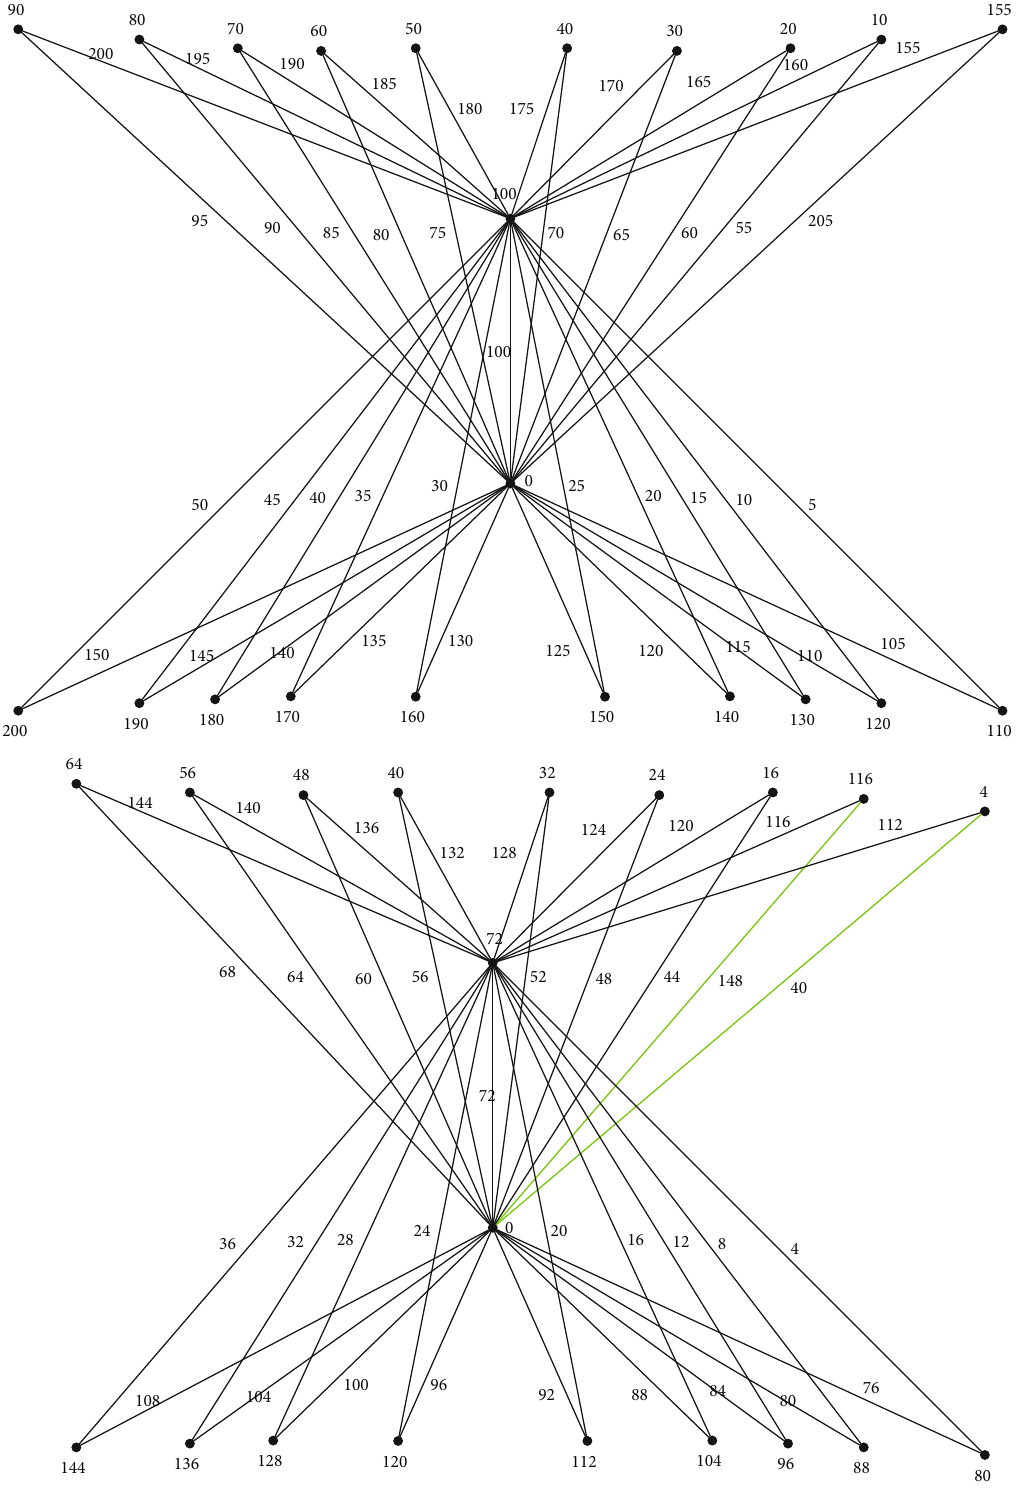
− graceful labeling and B Figure 20: B 10 with edge 5